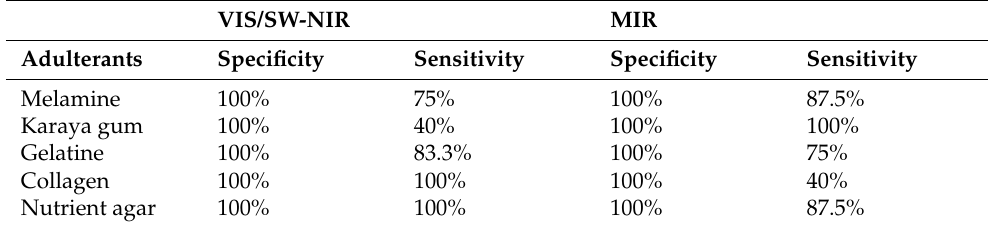
Table 6. The summary of statistical sensitivity and specificity of VIS/SW-NIR and MIR